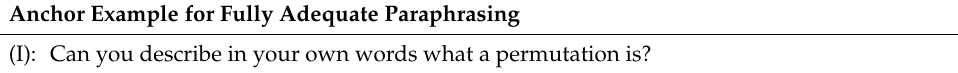
Table 6. Fully adequate paraphrasing of Participant I and P3 (cf. Table A3 in the Appendix A). Anchor Example for Fully Adequate Paraphrasing